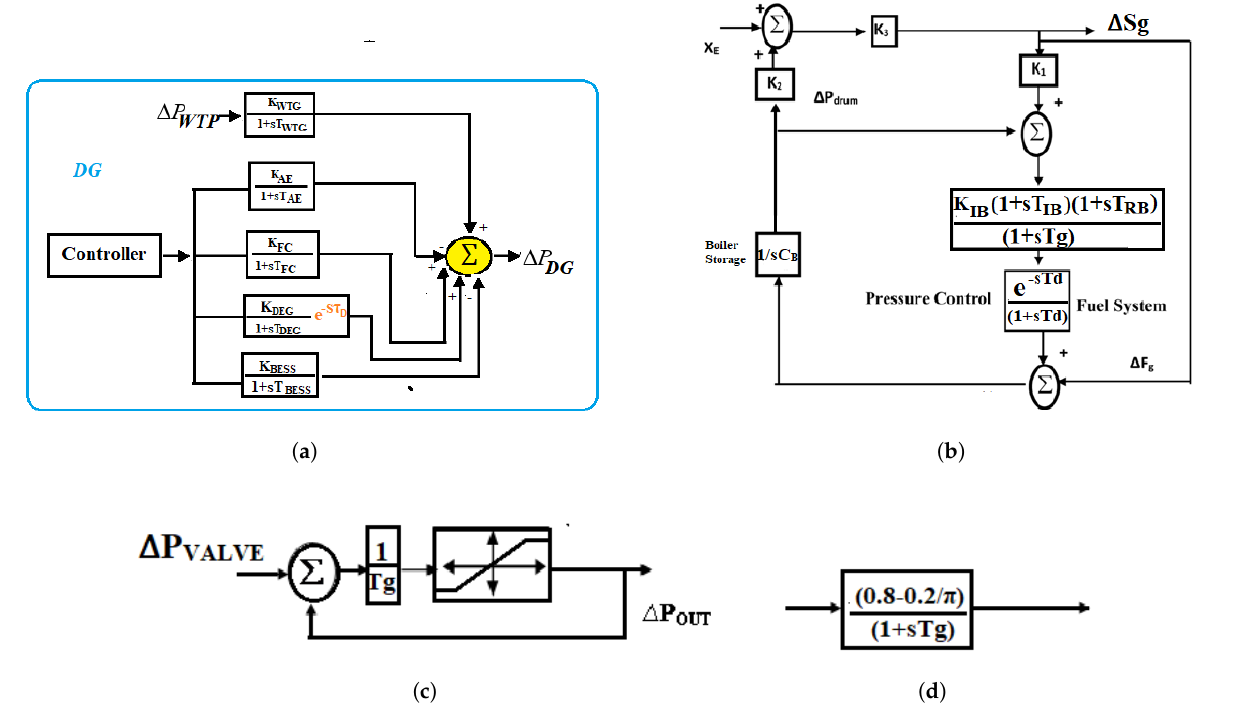
Figure 3. ( a ) Linearized model of DGS. ( b ) Schematic block diagram of boiler dynamics in test system 2. ( c ) Schematic Block diagram of GRC in test system 2. ( d ) Schematic diagram of governor dead − band in test system